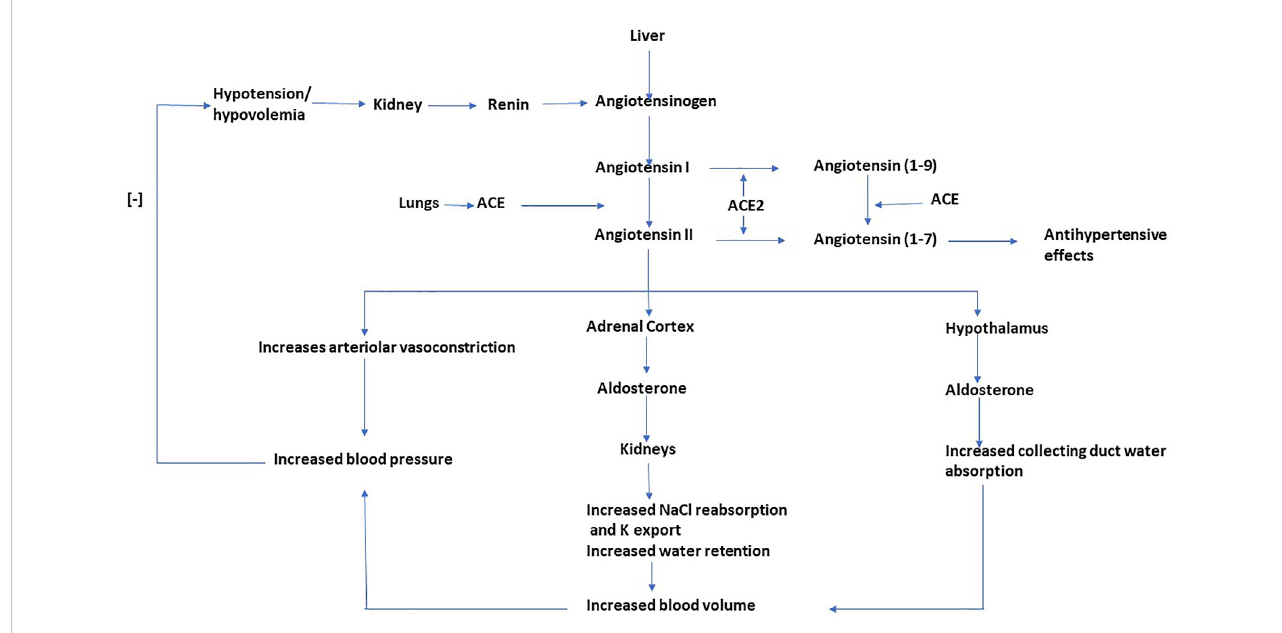
FIGURE 1 The role of RAAS in maintaining blood volume and blood pressure.